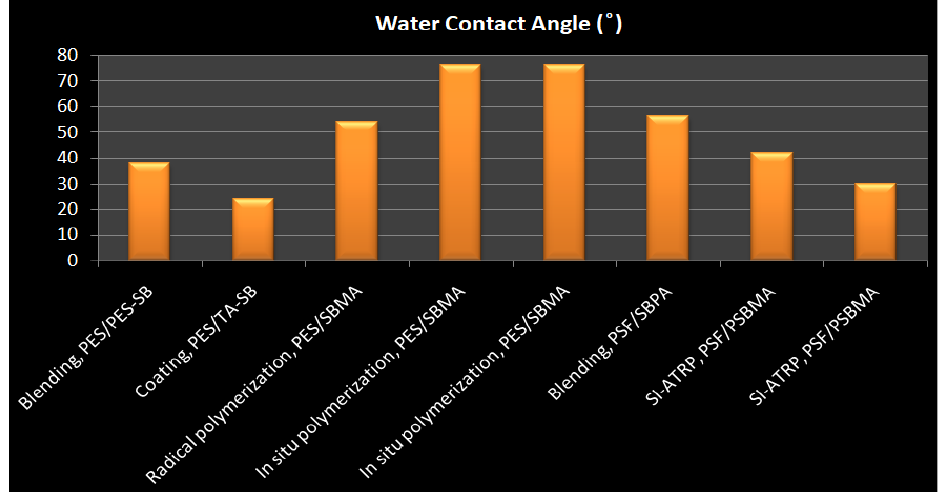
Figure 18. Comparison of WCA on modified SB Zwitterionic PES/PSF via different methods.